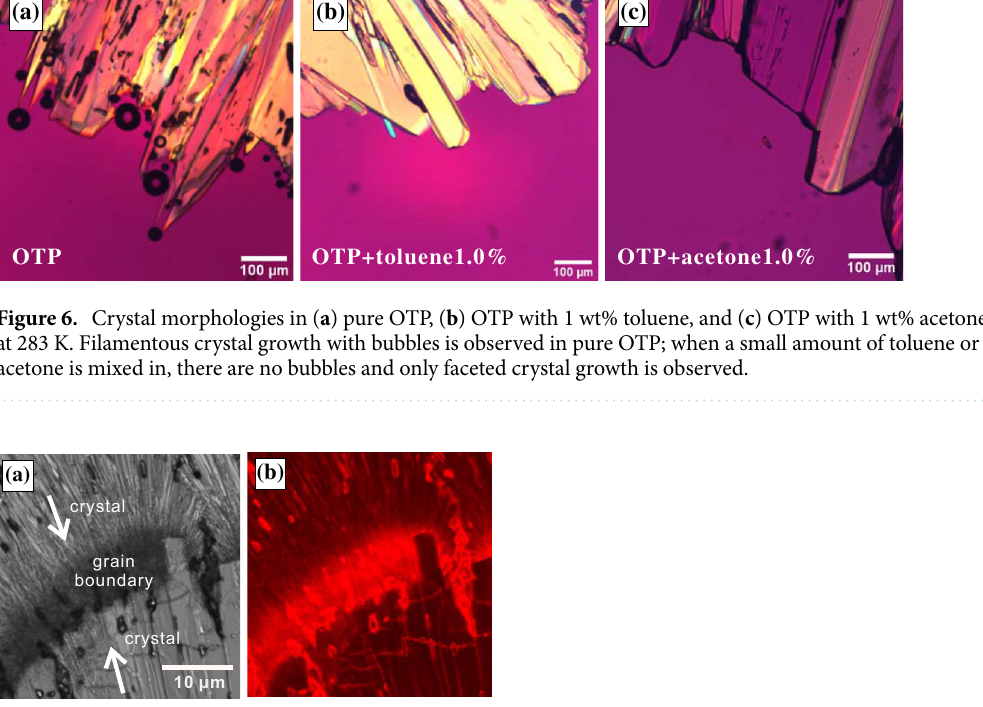
Figure 7. ( a ) Microscopy image and ( b ) fluorescence image of OTP with 1.0 wt% acetone+rhodamine 6G after the crystallization is finished. Those images are taken at the same position. The arrows indicate the directions of the crystal growth. Since the rhodamine 6G is not solved in OTP, the intensity corresponds to the acetone concentration. It is found that the grain boundary is bright, on the other hand, the crystal region is